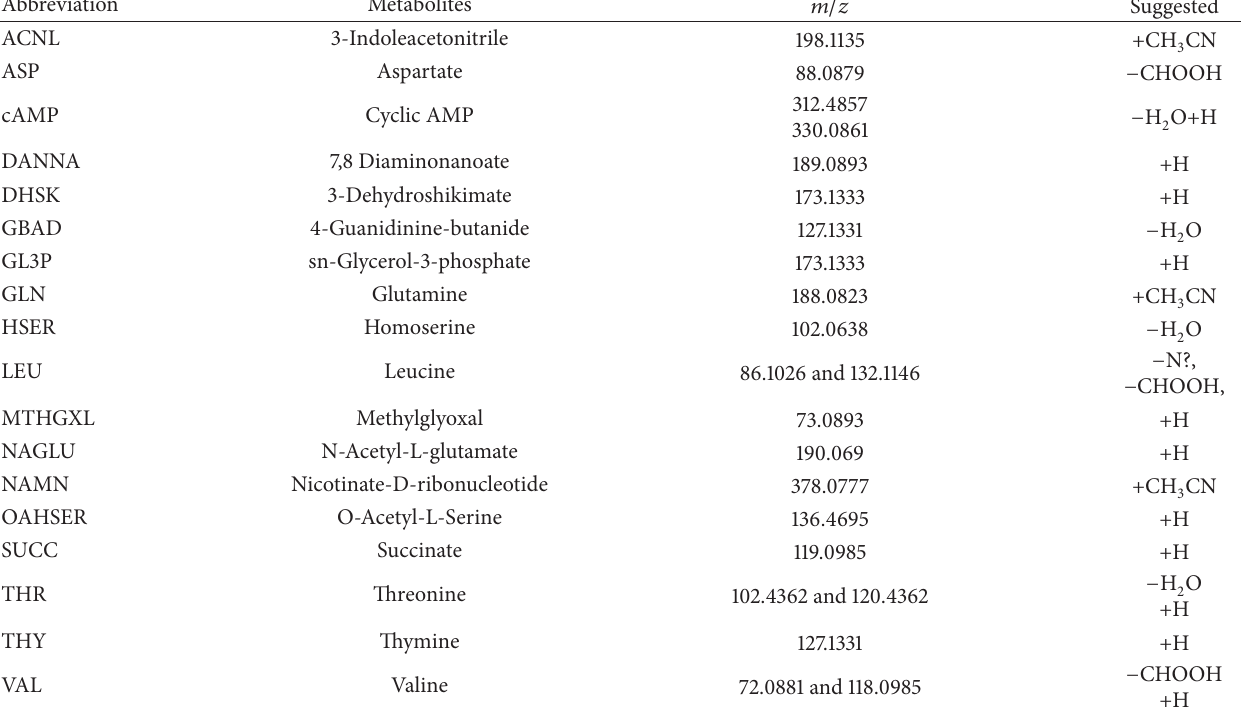
Table 5: List of key metabolites in positive ESI